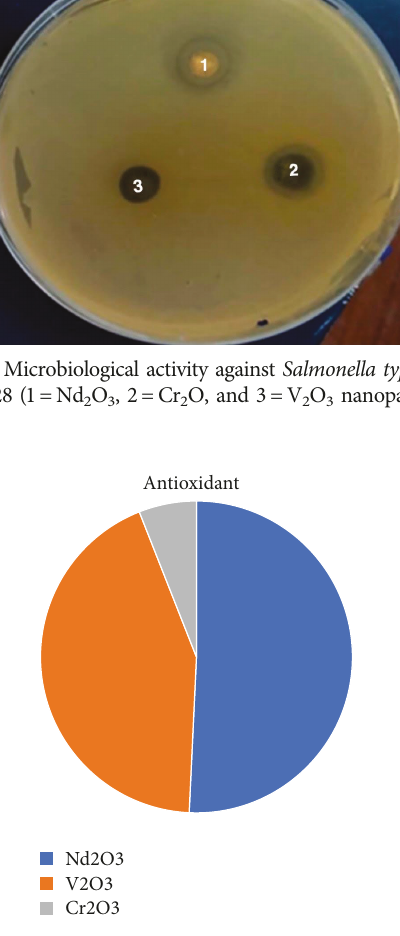
Nd2O3 V2O3 Figure 25: Antioxidant effect of MONPs